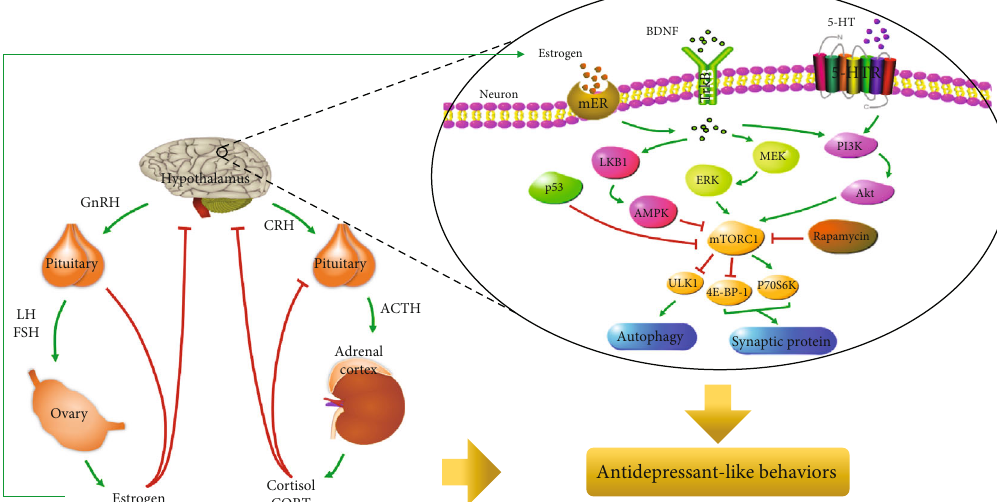
Figure 1: The regulatory e ff ects of the estrogen-BDNF-mTORC1 signaling pathway in depression. Green arrows indicate activation; T- shaped red arrows indicate inhibition. Abbreviations: 5-HTR: 5-hydroxytryptamine receptor; ACTH: corticotropin; AMPK: AMP- activated protein kinase; Akt: serine/threonine protein kinase; BDNF: brain-derived neurotrophic factor; CRH: corticotropin-releasing hormone; ERK: extracellular signal-regulated kinase; GnRH: gonadotropin-releasing hormone; LH: luteinizing hormone; LKB1: liver kinase B1; MEK: mitogen-activated extracellular signal-regulated kinase; mER: membrane estrogen receptor; mTORC1: mammalian target of rapamycin complex-1; PI3K: PI-3 kinase; TrkB: tyrosine kinase